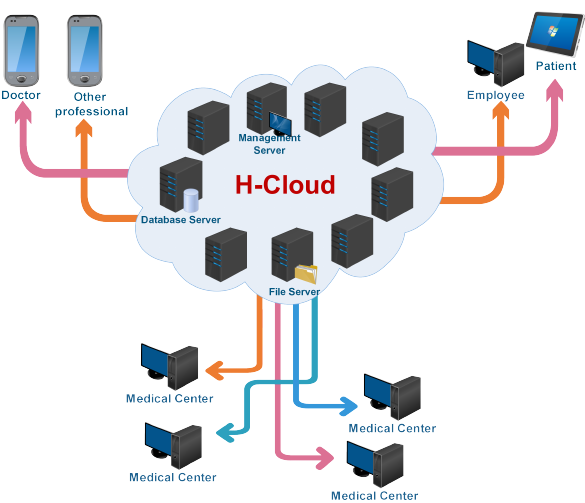
Figure 1. H-Cloud